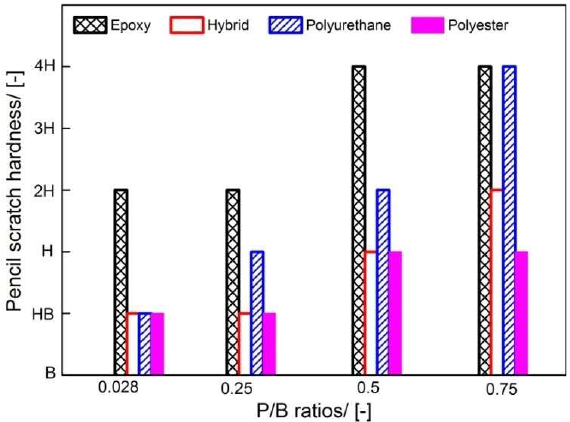
Figure 3. Pencil scratch hardness of formulations with different resins and P/Bs.